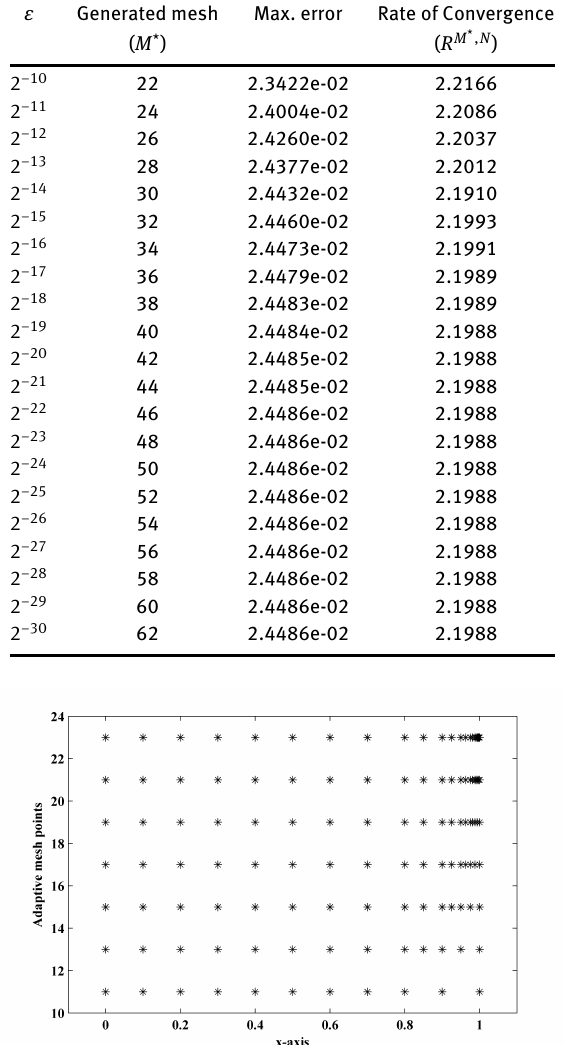
Fig. 1: Adaptive mesh generation for example 5.1 with ε = 2 −10 , δ = 0.6 , η = 0.7 , M=10(initially) and